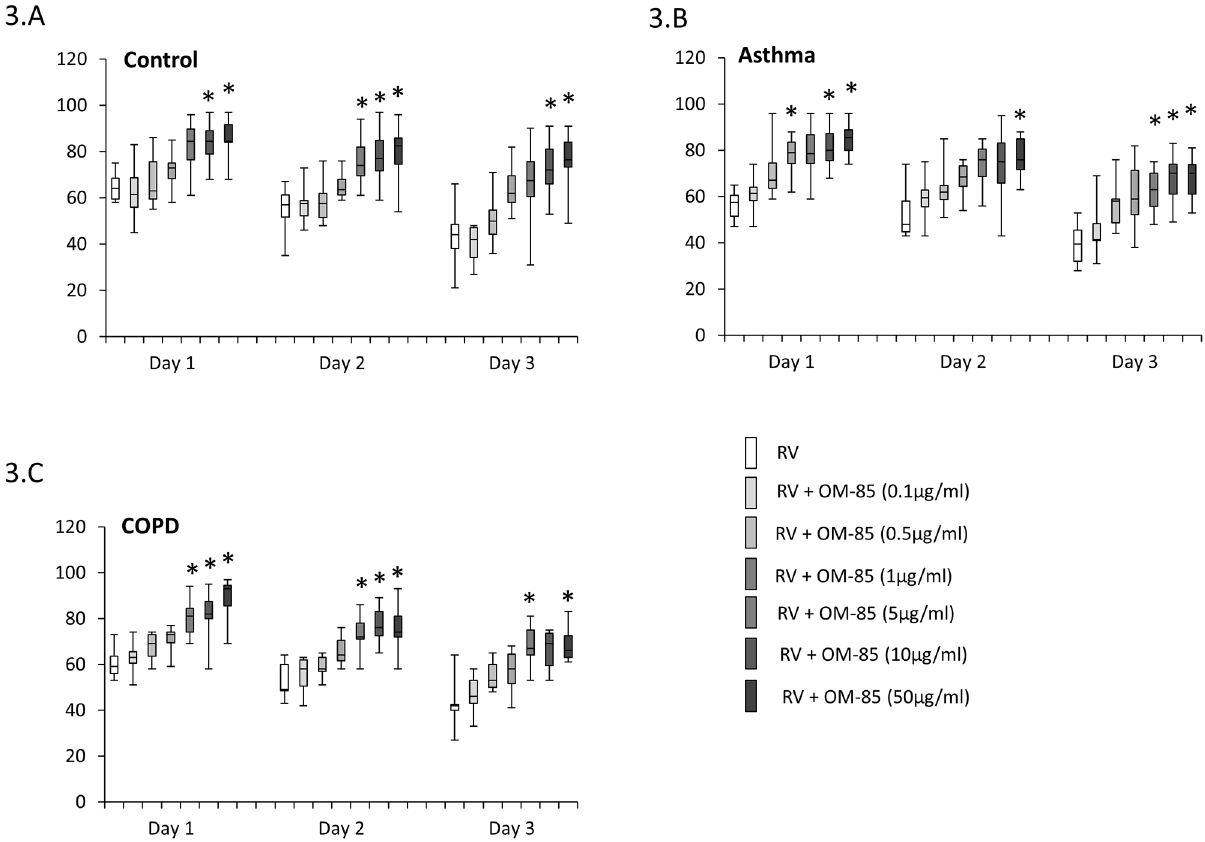
Fig 3. Dose-dependent preventive effect of OM-85 pre-incubation (2 days) on RV-induced cell death as determined by direct cell counting with Trypan blue exclusion staining. Box-plots represent medianand 95 % confidenceintervalsfor BEC derived from: (A) non- asthma, non-COPDcontrols (n = 8), (B) asthma (n = 9) and (C) COPD (n = 10). Statistics were performed with pairedStudent’s t-test, two- sided.